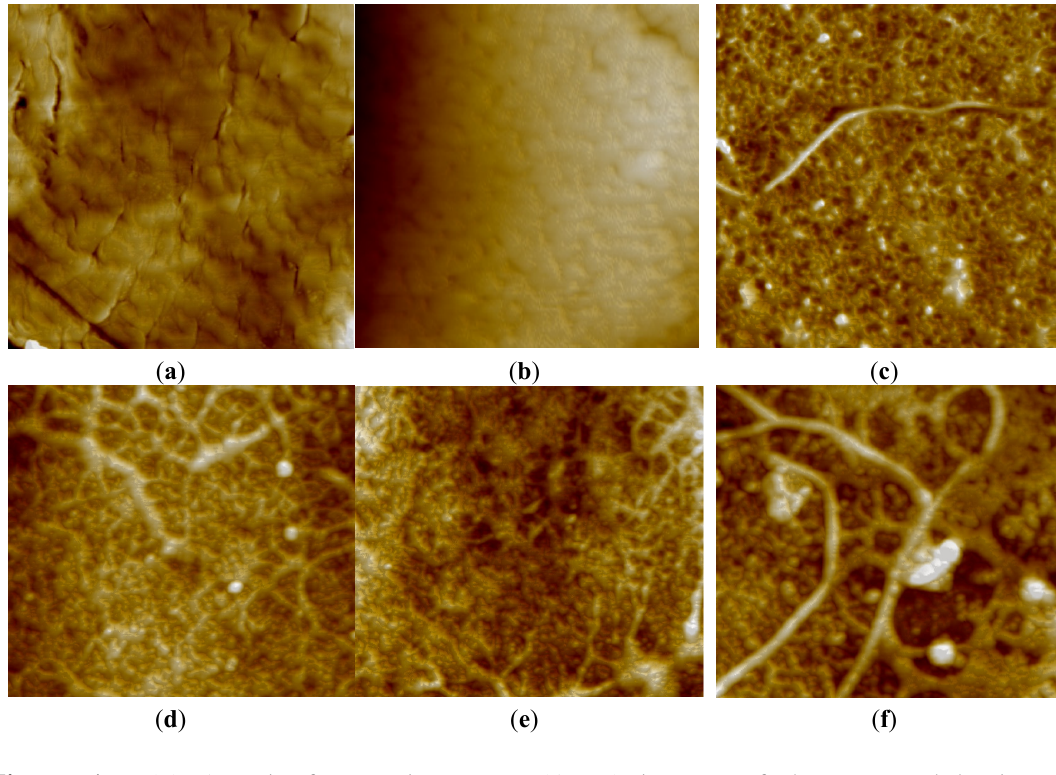
Figure 1. ( a ) Atomic force microscopy (AFM) images of the neat polylactic acid